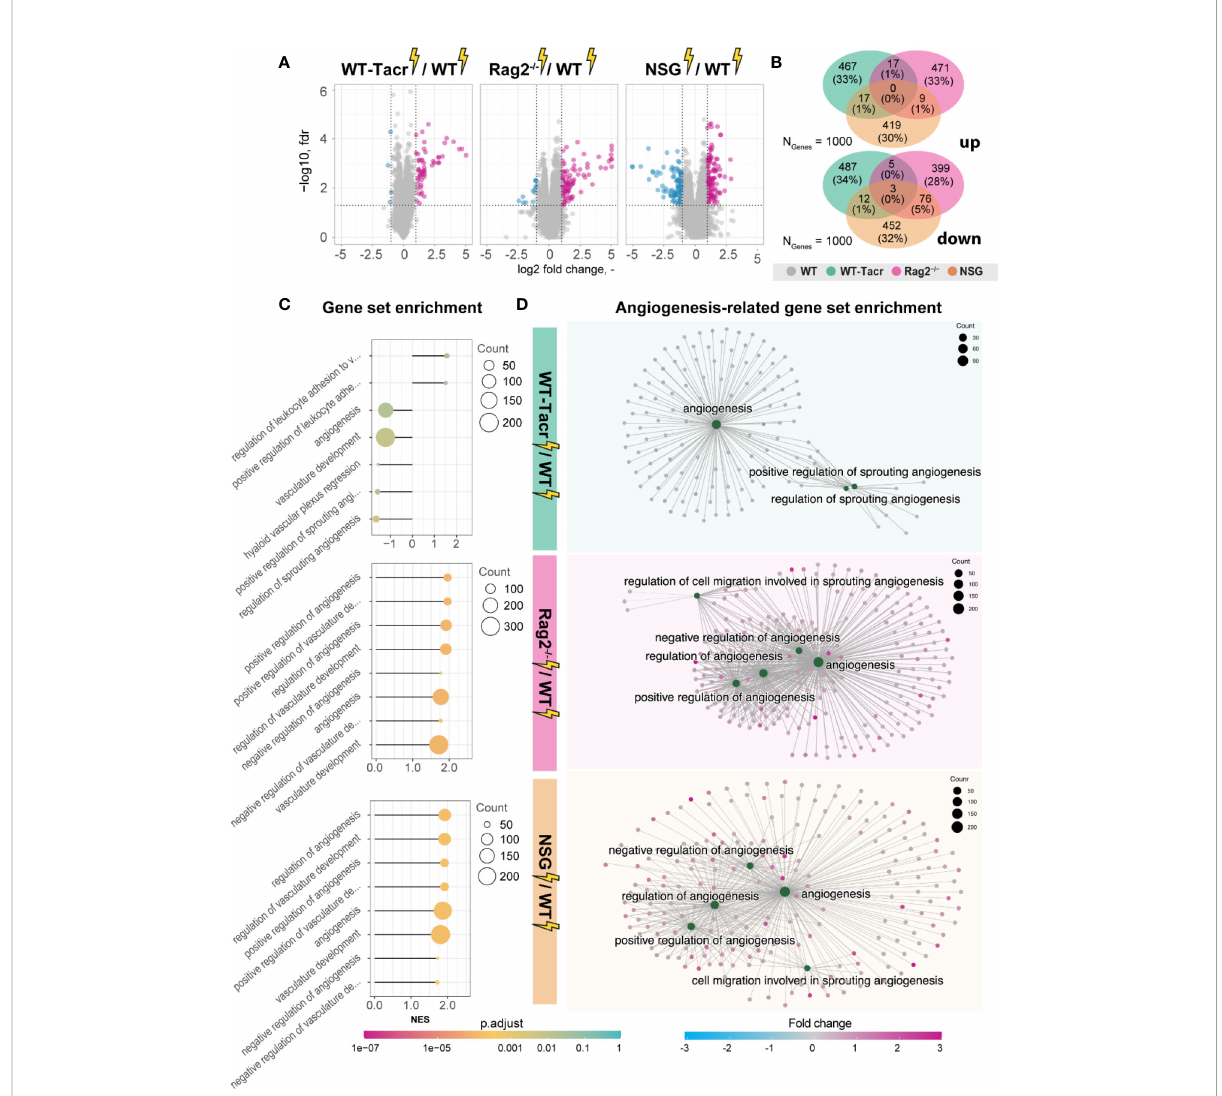
FIGURE 6 Gene expression changes and gene set enrichment between immunode fi cient stroked mice and wildtype stroke pathology. (A) Volcano plot of differentially expressed genes identi fi ed between immunode fi cient stroked mice and wildtype stroked mice. Magenta dots indicate upregulated gene expression, and blue dots indicate downregulated gene expression. (B) Venn diagram of common and differentially expressed top1000 genes in all groups of stroked immunode fi cient mice. (C) Gene set enrichment shown in a lollipop plot in immunode fi cient stroked mice compared to wildtype stroked mice. Size of dots represents the number of genes in the pathway and color of dots represents adjusted p value. (D) CNET plot describing linkages of genes and biological processes for angiogenesis-related pathways. Size of dots represents the number of genes in the pathway and color of dots represents fold